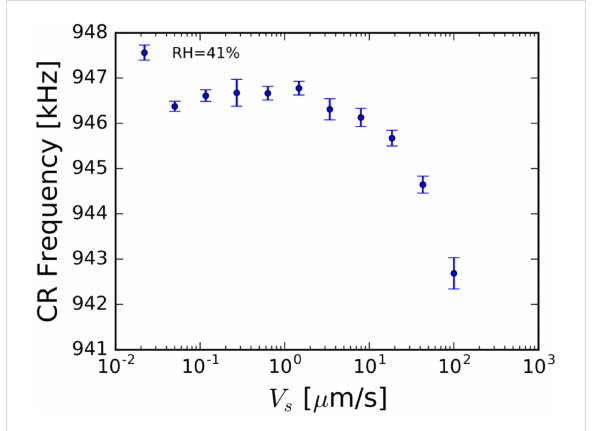
Figure 3: The measured in-contact resonance frequency of the second mode of an AFM cantilever as a function of the dynamic scan speed on a mica surface at 100 nN force set-point, 41% relative humidity, and a scan angle of 90°. The measured in-contact frequency is clearly affected by scan speed. Additionally, this phenomenon is ob- served at a speed two orders of magnitude lower than reported by Picco and co-workers [15]. Error bars represent one standard devia- tion from the